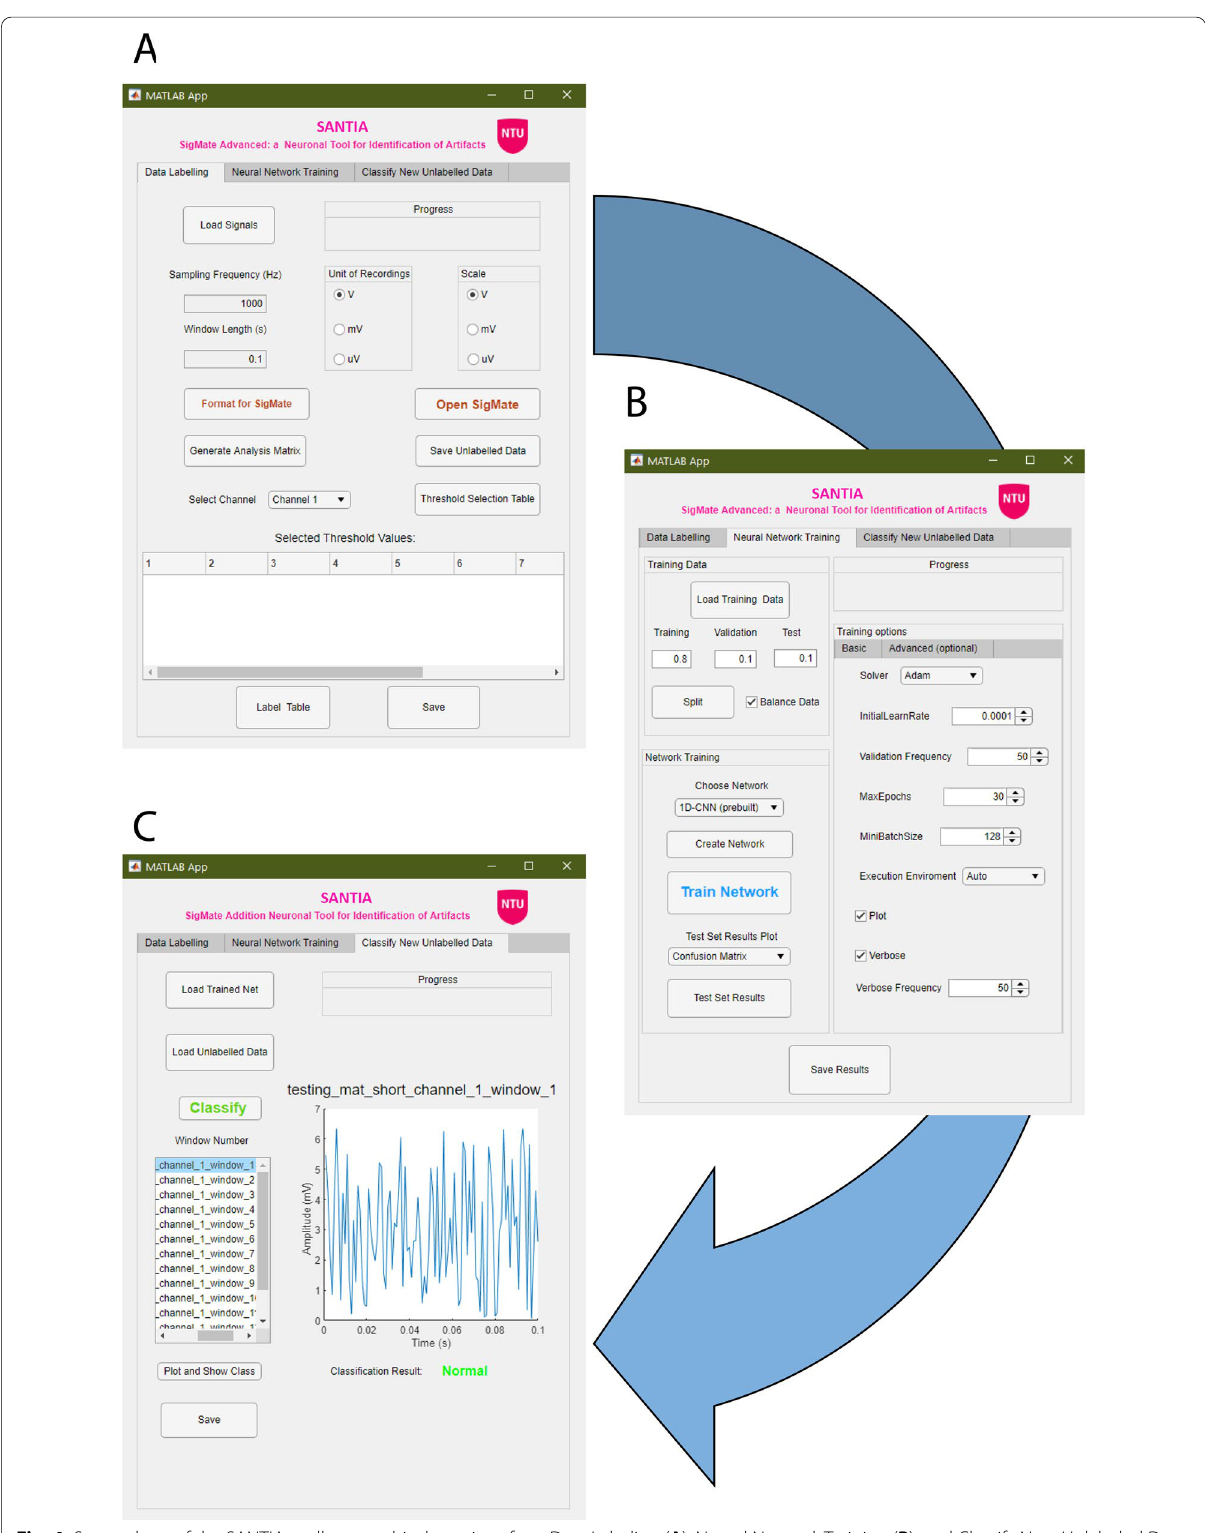
Fig. 4 Screenshots of the SANTIA toolbox graphical user interface: Data Labeling ( A ), Neural Network Training ( B ), and Classify New Unlabeled Data ( C